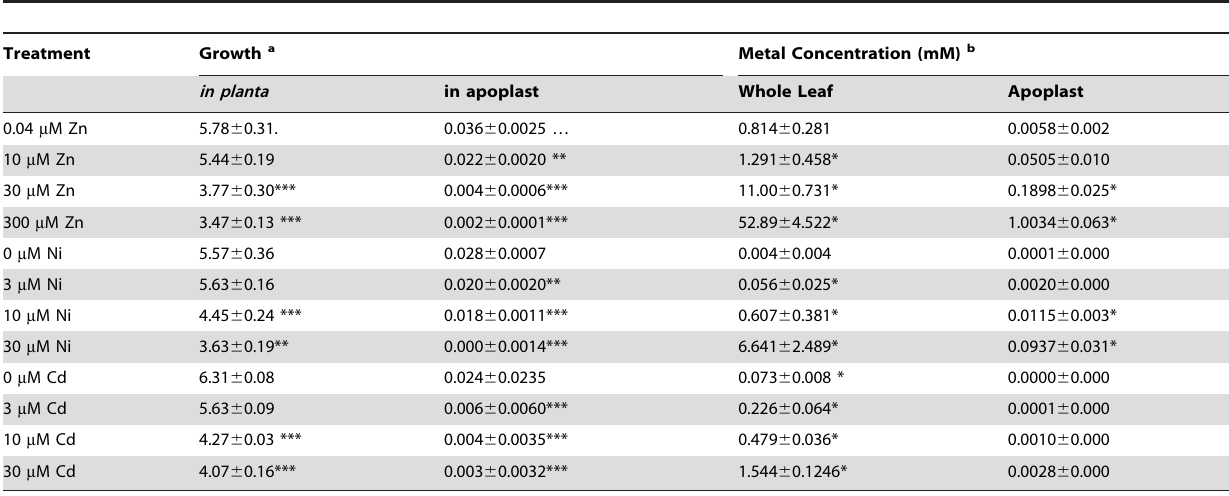
a ‘Growth’ indicates mean log bacterial cells/cm 2 leaf 5 days after inoculation ( in planta ) or increase in OD over 18 hours in vitro in extracted apoplast. Means found to be significantly different from the control mean (Bonferroni simultaneous comparisons) are marked with *( a =5%), **( a =1%), or ***( a =0.1%). In the case of Ni in planta data, the 3 m M treatment was used as a control for statistical analysis because of the relatively high variability of the 0 m M treatment. b Metal concentrations of either bulked whole leaf samples or of the apoplast are shown. * indicates that concentrations were equal to or greater than the IC the respective metals for Psm in extracted apoplast.